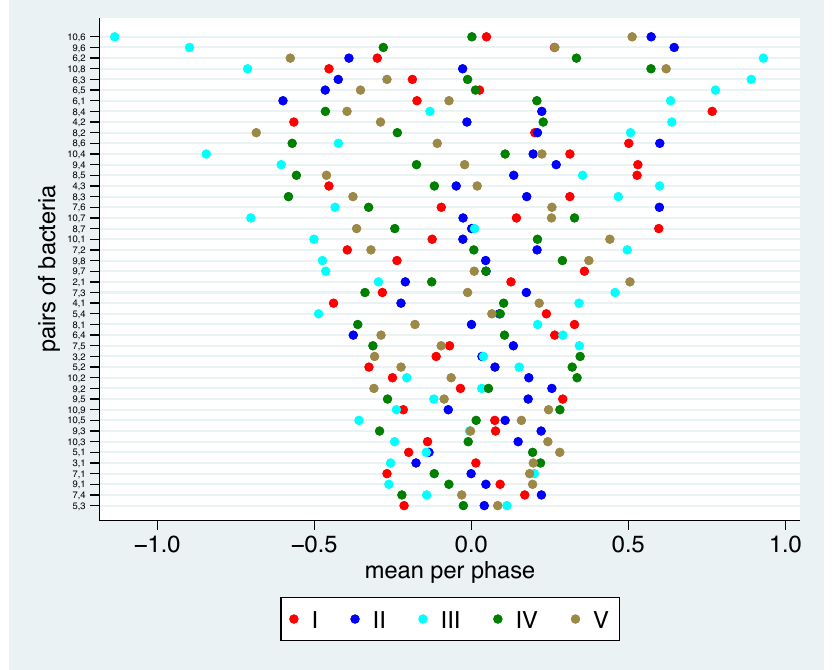
Figure 4. Mean log ratios for all bacterial pairs of bacterial groups and phases. The values are centred around 0 for each bacterial pair. The bacterial pairs are ordered according to the range of the mean